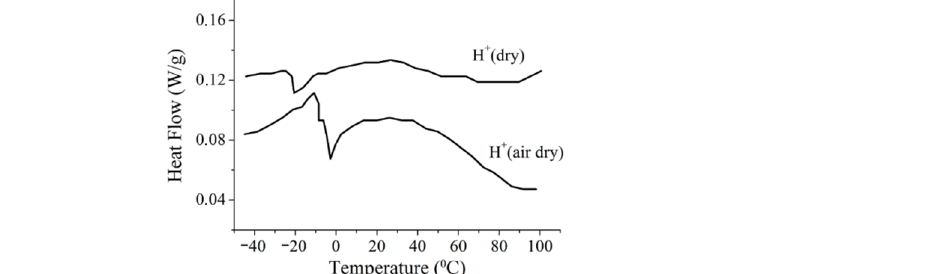
Figure 15. DSC thermograms in H + ionic forms of perfluorinated sulfo cation-exchange MF-4SC membrane, which is a complete analog of Nafion. “Dry” means that the sample was dried to a constant weight at 120 ◦ C ( λ is about 2 water molecules per sulfonate group), “air dry” means the sample dried to a constant weight at room temperature ( λ is about 5 water molecules per sulfonate group). Adapted from [44].